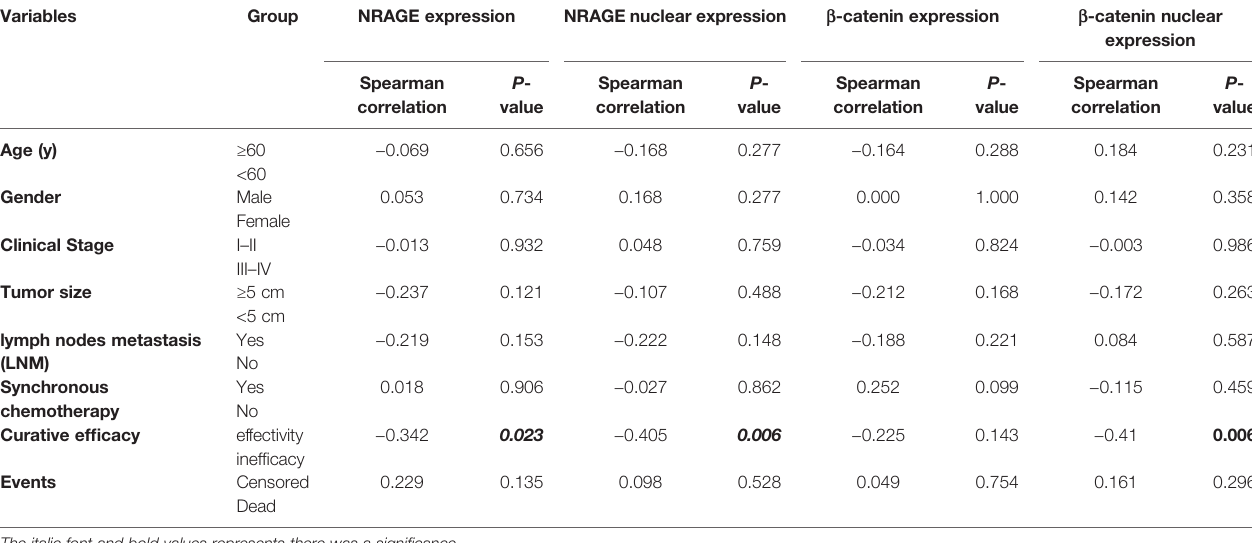
TABLE 1 | Spearman analysis of correlation among NRAGE, b -catenin and clinicopathological